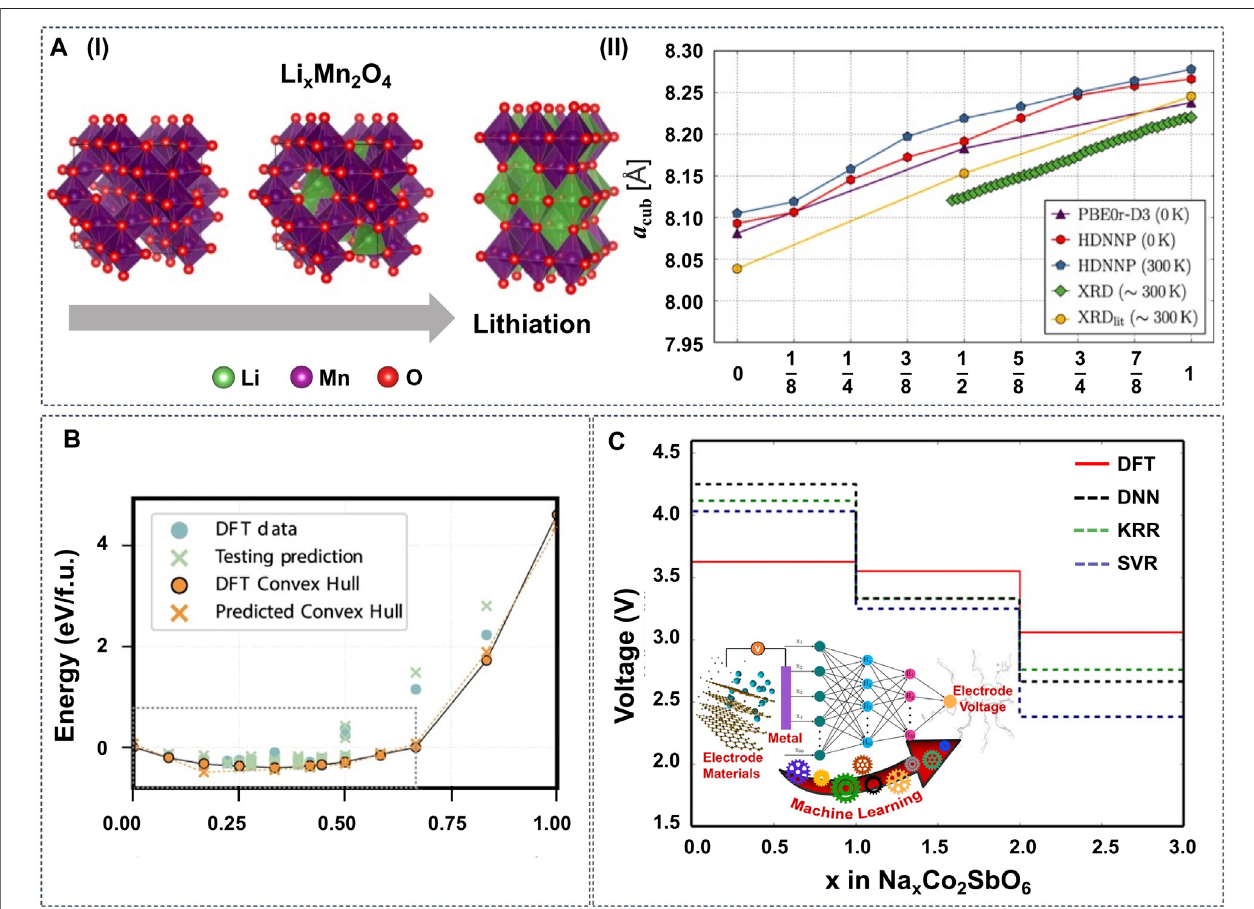
FIGURE 4 | (A-I) Li x Mn 2 O 4 spinel structure with different x (x (cid:1) 0, 1, 2). The green, red, and purple balls represent Li, O and Mn atoms, respectively. (A-II) Cubic lattice parameter a cub as a function of Li content determined by DFT on the PBE0r-D3 level of theory (0 K), high-dimensional neural network potentials (HDNNP) (0 and 300 K)andXRDmeasurements.Reproducedwithpermissionfrom(Eckhoffetal.,2020b).Copyright2020AmericanPhysicalSociety. (B) Formationenergiespredicted byanANNpotentialforlithium-vacancyorderingsonthetetrahedralandoctahedralsitesofspinelTiS 2 ,withthelocalfeaturesaroundeachsitegeneratedfromonly pair correlations. Reproduced with permission from (Natarajan and Van der Ven, 2018). Copyright 2018 Nature. (C) Voltage pro fi le diagram obtained from different ML models and DFT for Na x Co 2 SbO 6 . Reproduced with permission from (Joshi et al., 2019). Copyright 2019 American Chemical Society.